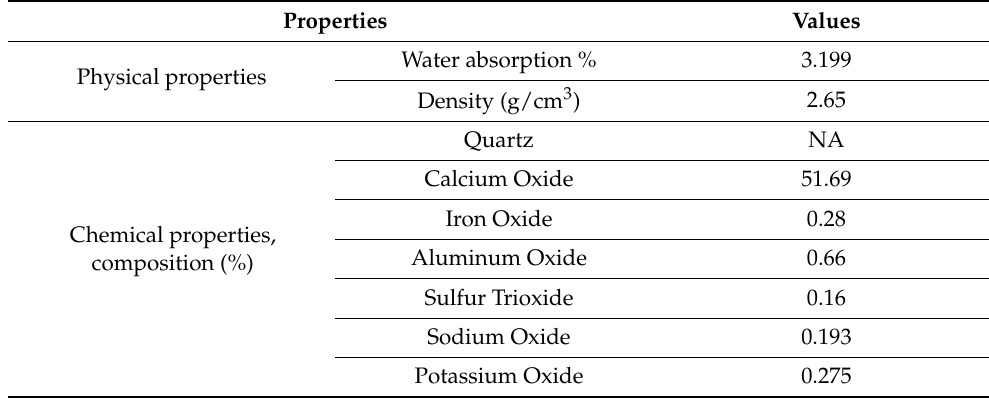
Table 1. Basic properties of the recycled concrete aggregates.